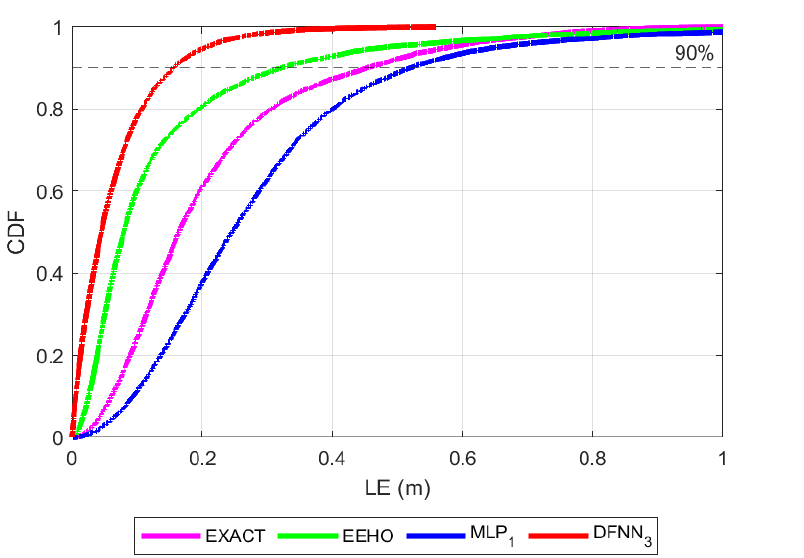
Figure 9. Cumulative Distribution Function of LE for σ 2 ν